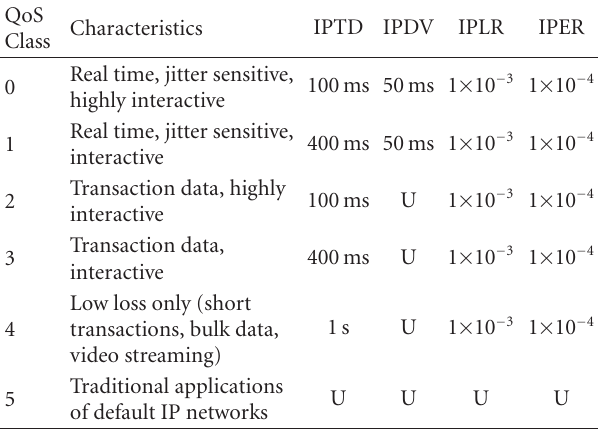
Table 6: IP QoS classes and objective performance-metric upper limits (U-Unspecified)